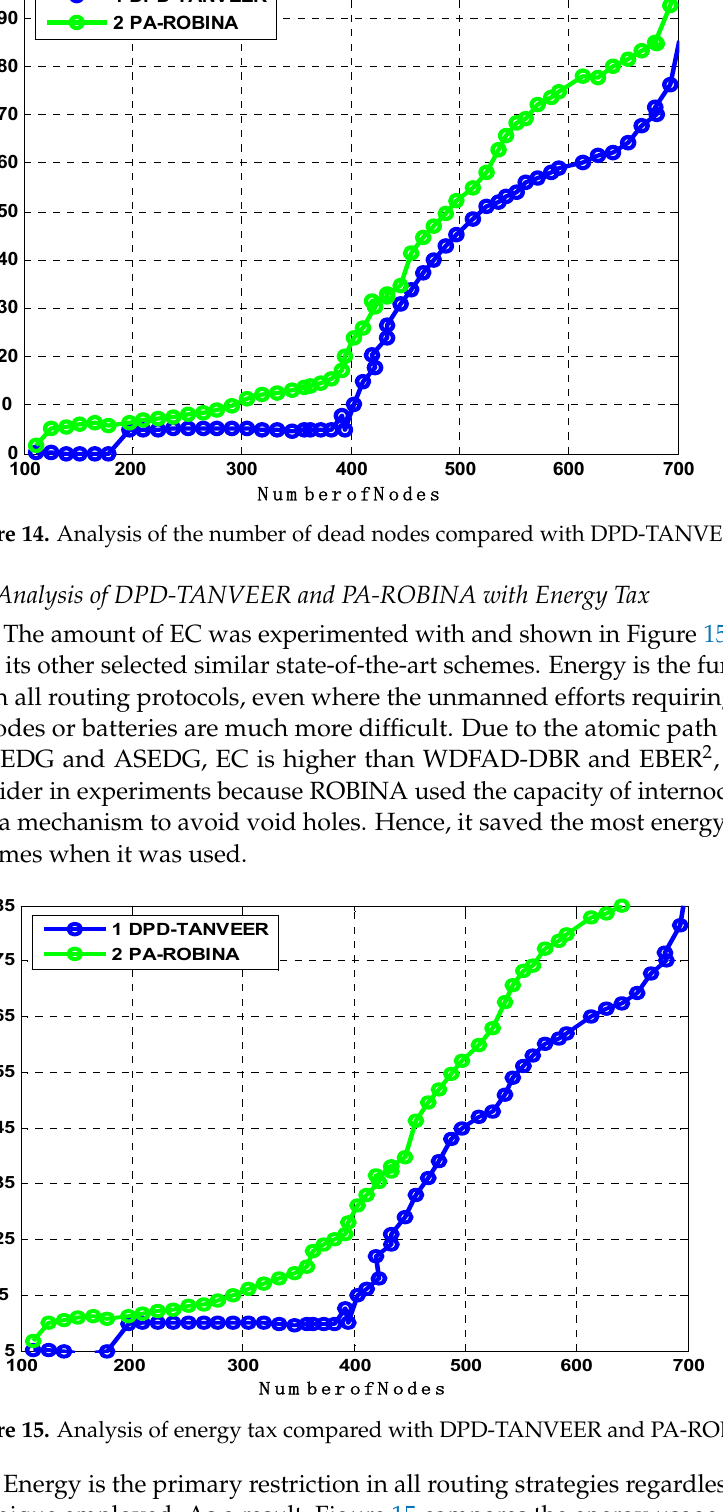
Figure 13. Analysis of the number of dead nodes compared with DPD-TANVEER.